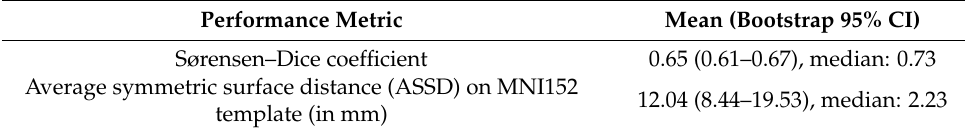
Table 2. Segmentation performance of the trained model across cross-validated folds.